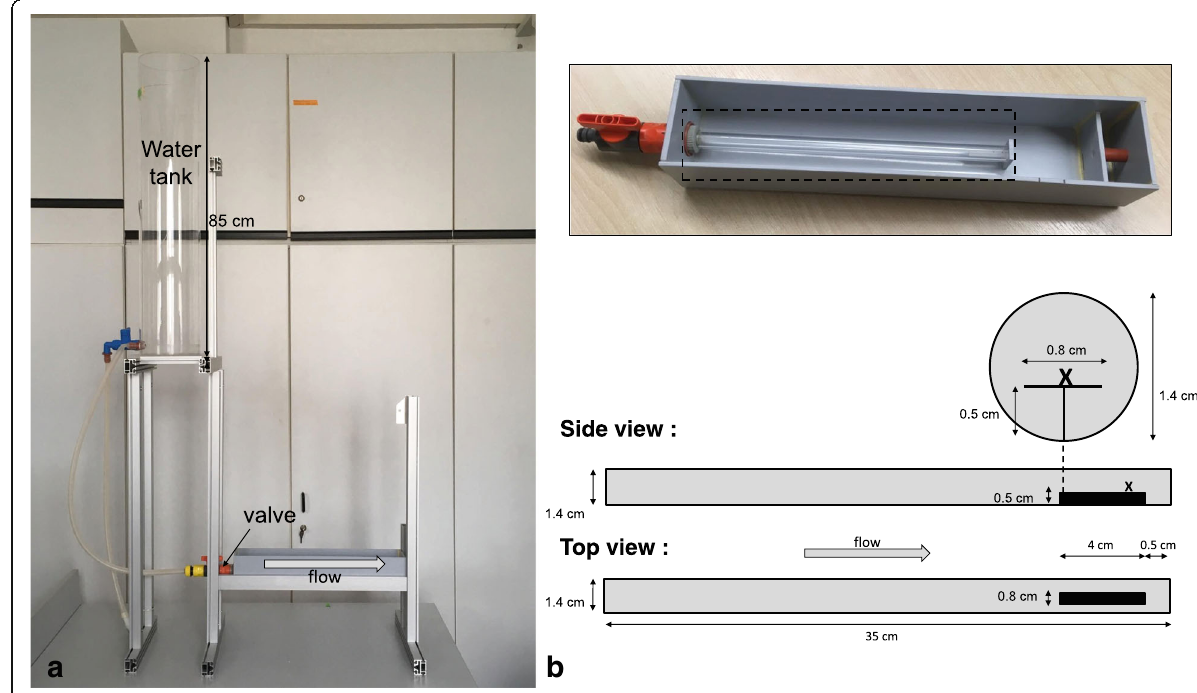
Fig. 3 Flow tank setup ( a ) and close-up of the cylindrical pipe ( b ). Cross = initial position of